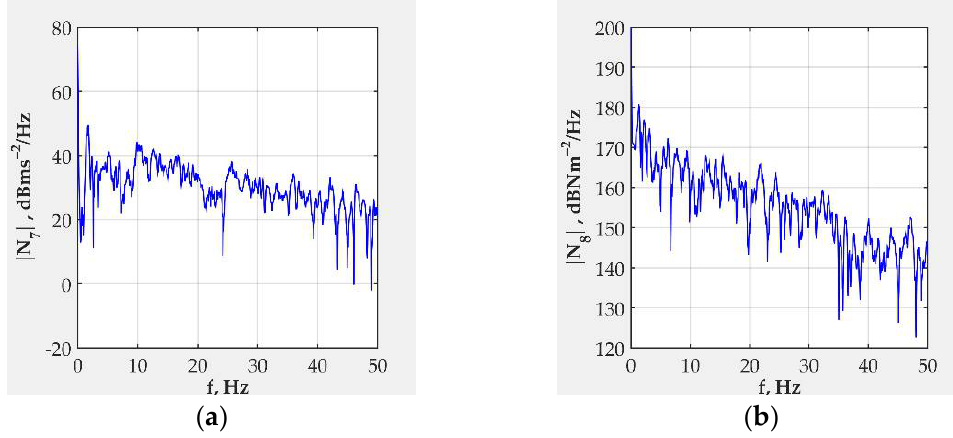
N . Figure 10. Magnitudes of output noise spectra: ( a ) N 7 ; ( b ) N 8 . 8